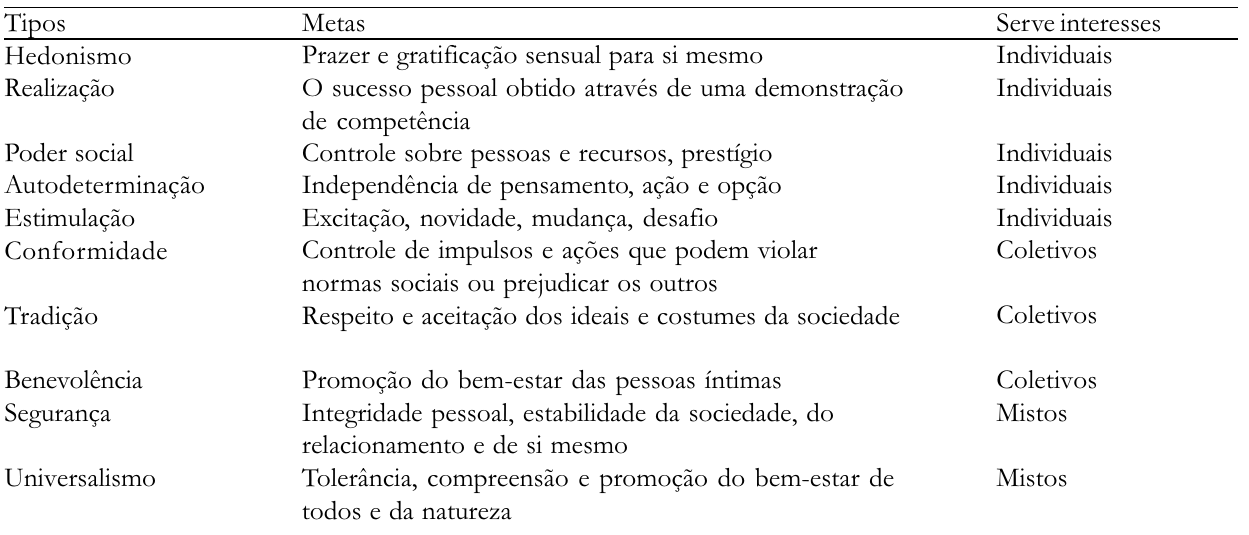
Tabela 1. Tipos Motivacionais de